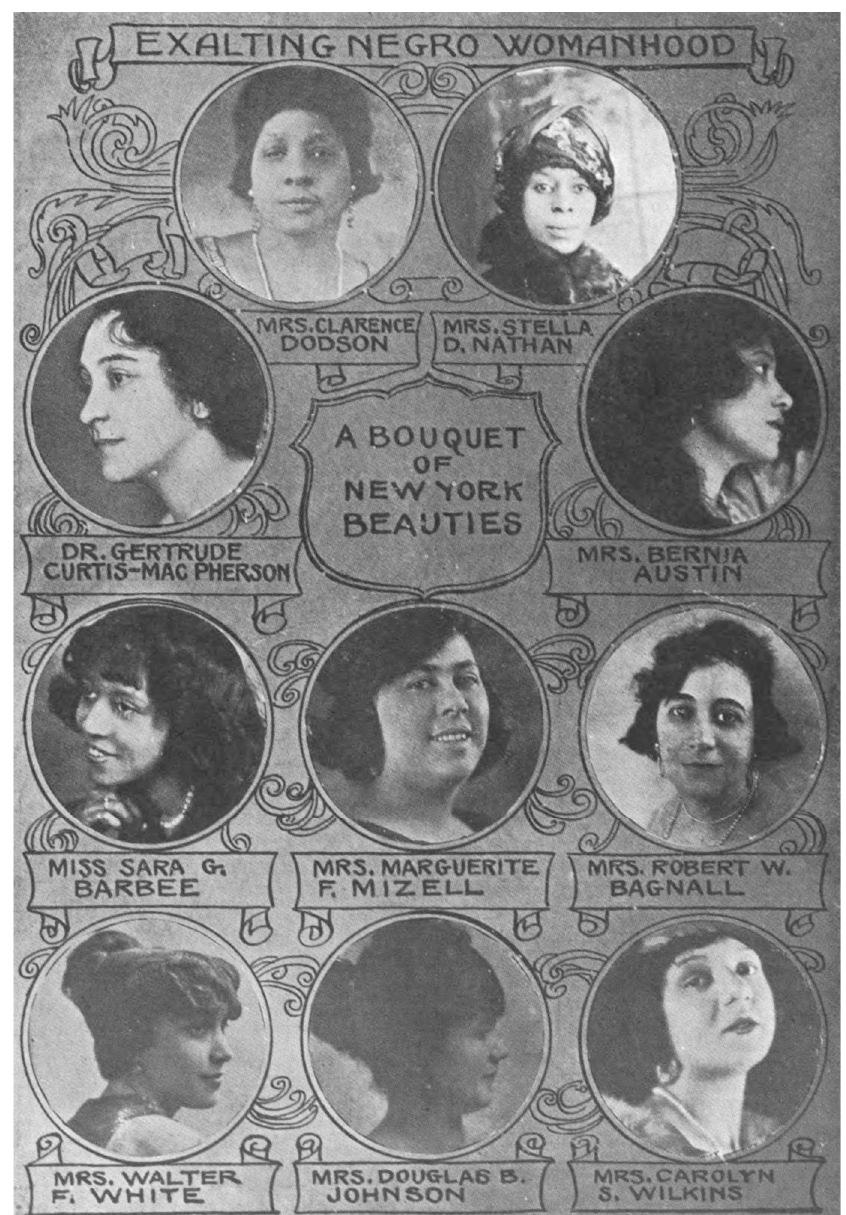
Figure 1. “Exalting Negro Womanhood”. The Messenger , January 1924, p. 22. Accessible online: https://hdl.handle.net/2027/inu.32000004071702 (accessed on 16 August 2022).